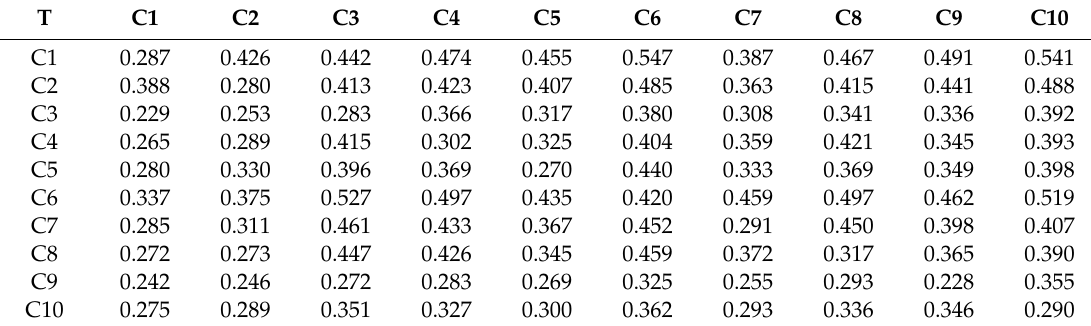
Table 4. Total influence matrix T.